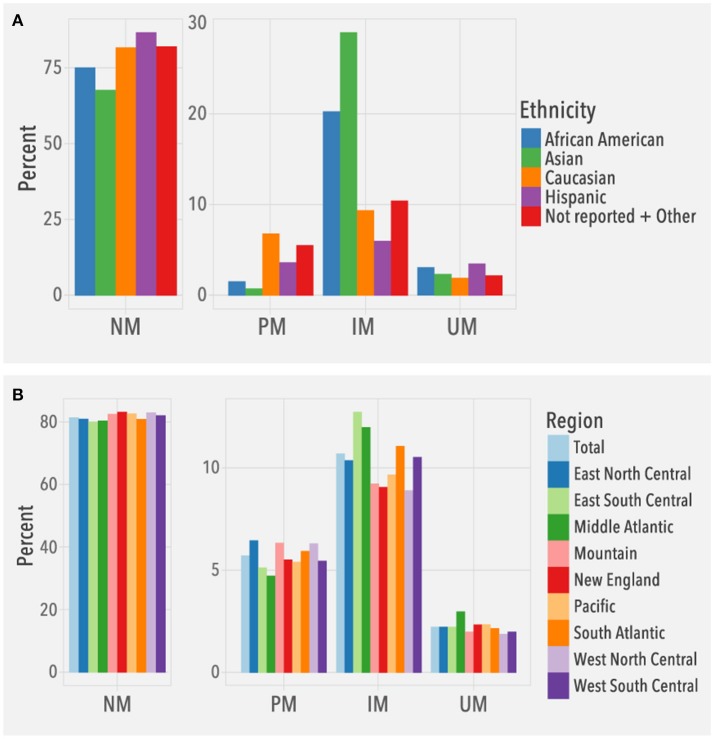
Predicted phenotype frequencies. Frequencies are based on (A) ethnicity (N = 104,509) and (B) geographical regions (N = 104,384; Puerto Rico not included). NM, normal metabolizer, PM, poor metabolizer, IM, intermediate metabolizer, UM, ultrarapid metabolizer.